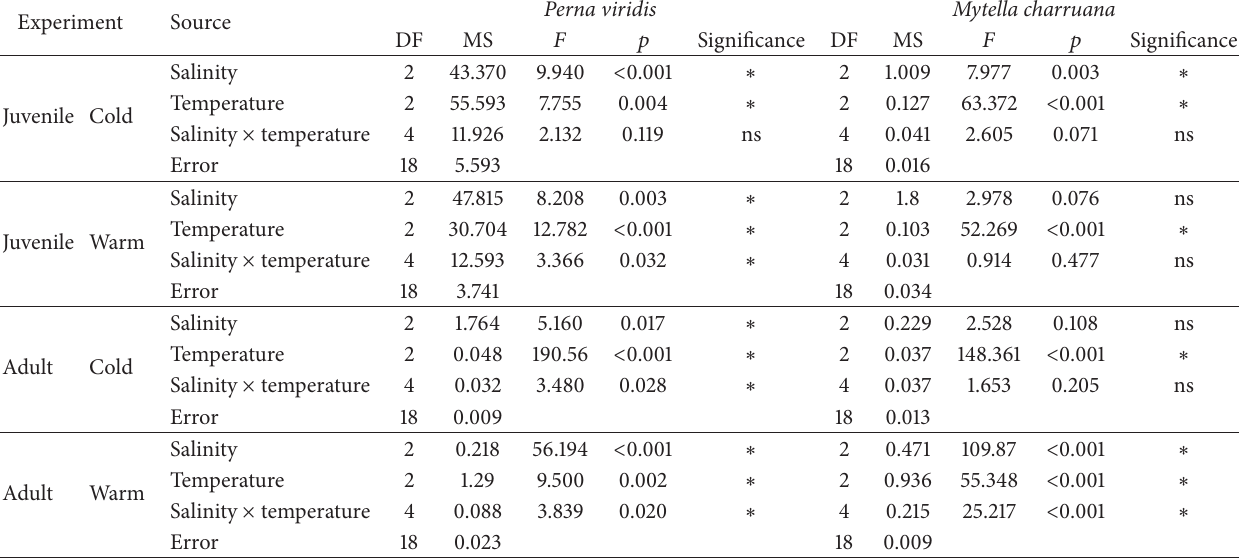
Table 3: Two-way ANOVA tables: interaction between salinity and temperature on nonnative mussels. Experiment